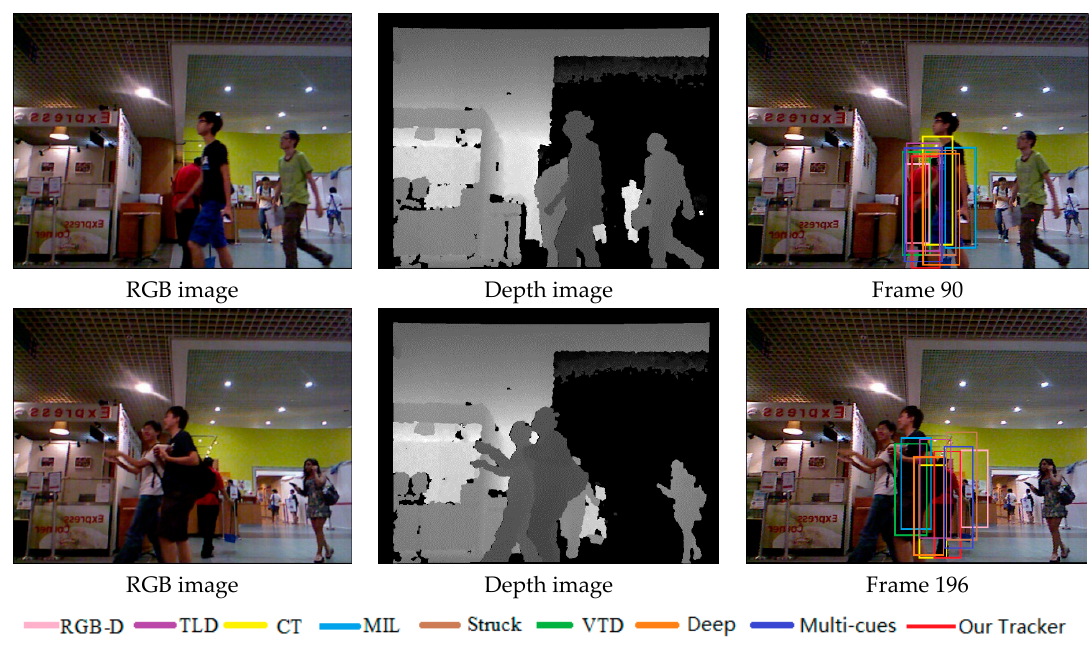
Figure 8. The tracking results on the test video 2 obtained by different methods.